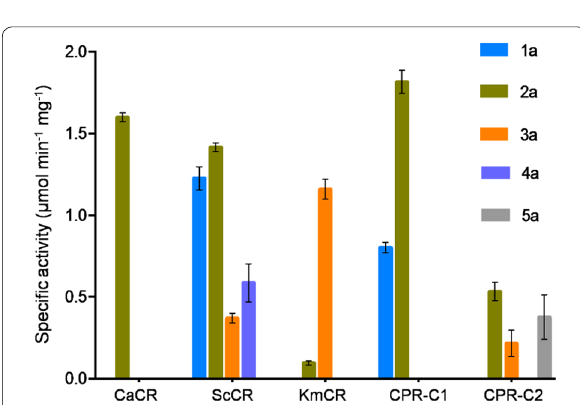
Fig. 3 Substrate specificities of the enzymes towards the tested carbonyl substrates, including (1a) methyl benzoylformate, (2a) ethyl benzoylformate, (3a) ethyl 2-oxo-4-phenylbutyrate, (4a) ethyl benzoylacetate, and (5a) 1-benzyl-3-pyrrolidinone. The reaction mixture consisted of 0.1 M sodium phosphate buffer (pH 6.5), 0.5 mM NADPH, 5 mM substrate, and the appropriate enzyme in a total volume of 100 µL. The experiments were carried out in triplicate, and the error bars represent the standard error of the